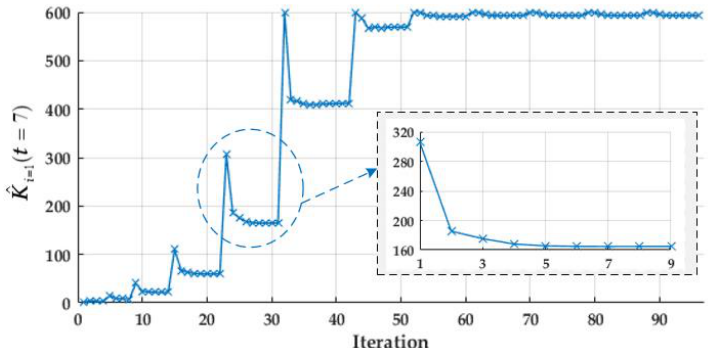
t Figure 10. The dynamic process for customer 1 to estimate ˆ K i = 1 ( t = 7 ) based on the proposed